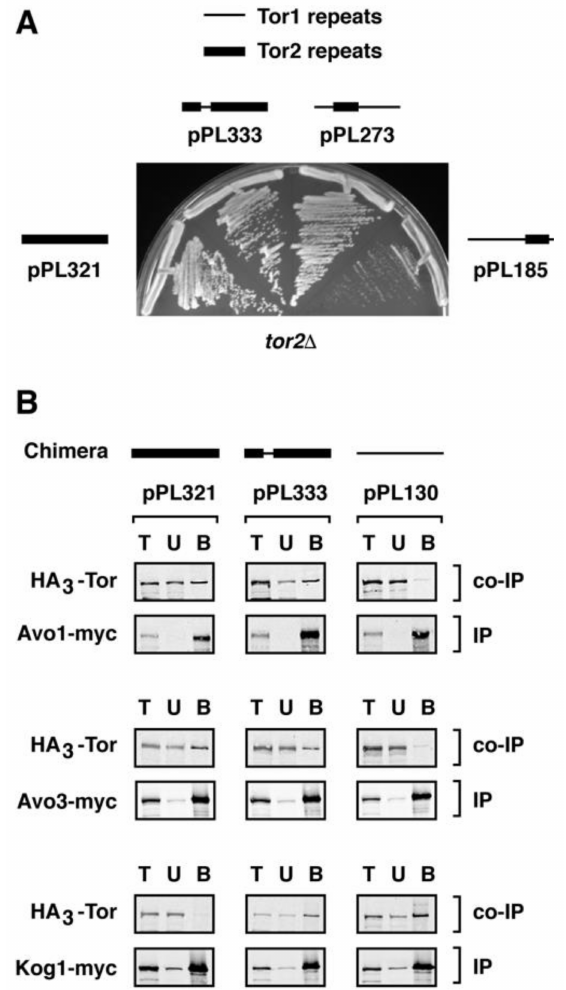
Figure 7. Testing the effects of replacing the Major Assembly Specificity (MAS) domain from Tor2 with Tor1 in chimera 333. ( A ) Growth properties of chimera 333 at 30 ◦ C, demonstrating robust rescue of the lethality of tor2 ∆ cells. ( B ) Chimera 333 associates stably with components of both TORC1 and